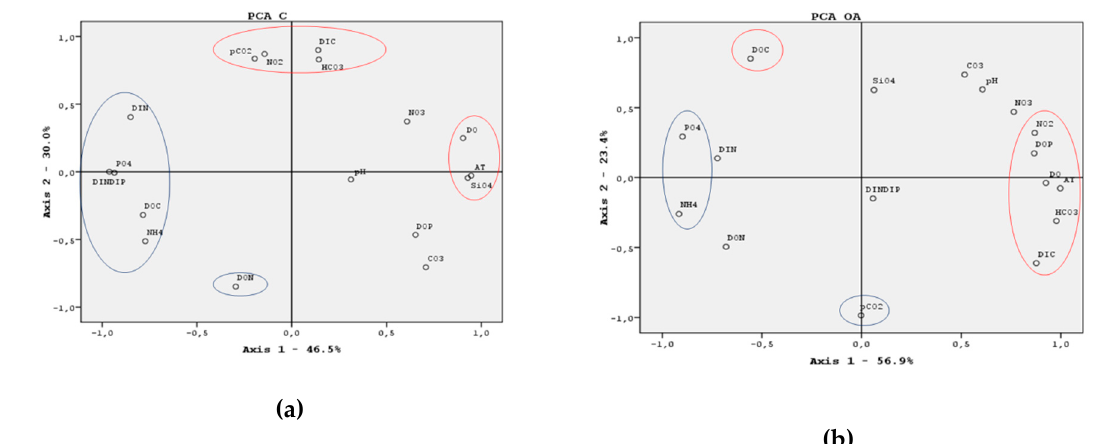
Figure 11. Principal component analyses (PCA) graphs for ( a ) C and ( b ) OA treatments. Red circles indicate positive significant correlations while blue circles indicate negative significant correlations.